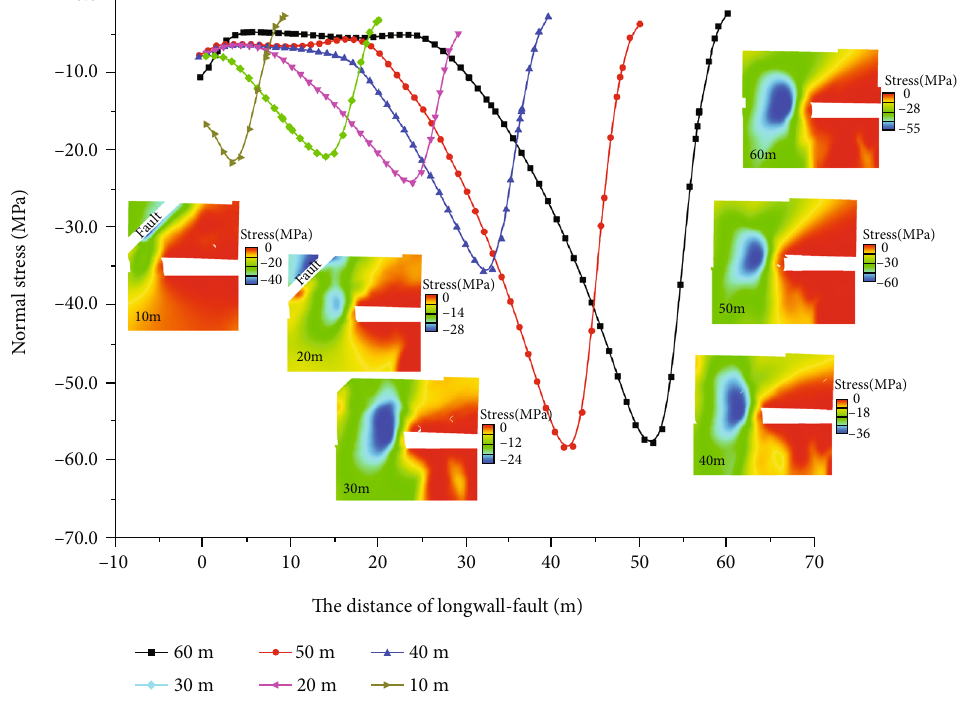
Figure 6: Vertical stress and nephogram of the coal seam in excavation stage 2 of the longwall face.